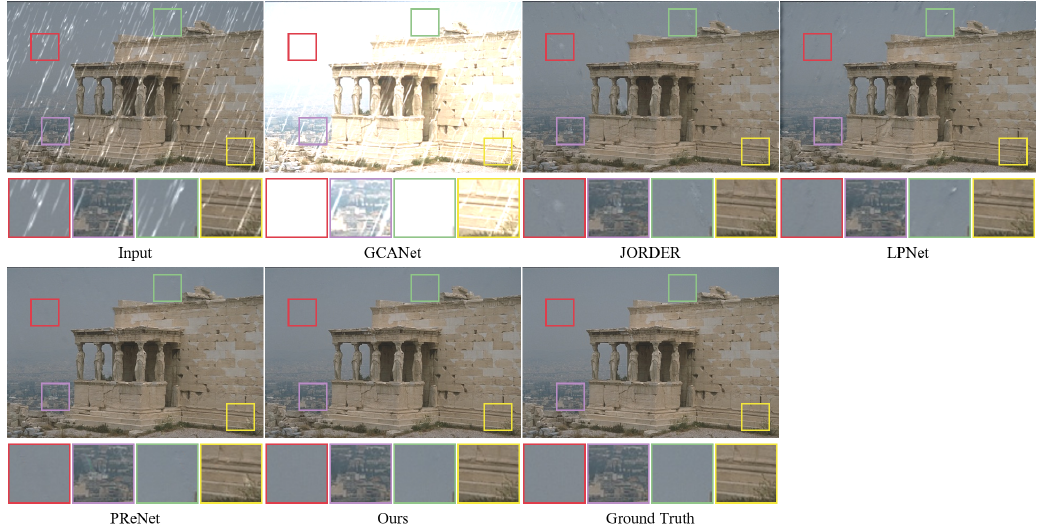
Figure 5. The performance of different methods on synthetic dataset (Rain100L).